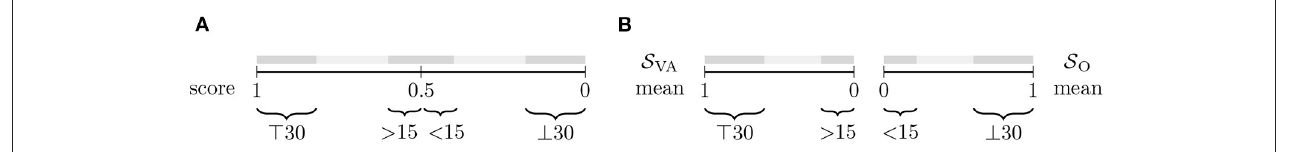
FIGURE 5 | Selection of samples for evaluation of the classification task (A) and of the sequence tagging task (B) .